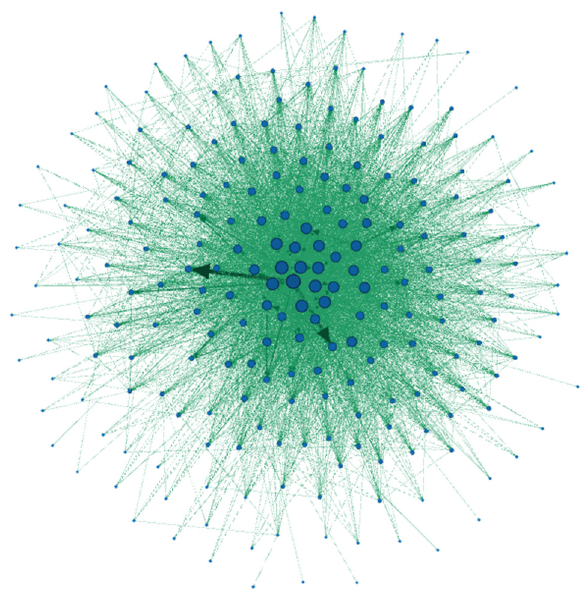
Figure 1. The agricultural trade network in 2019.